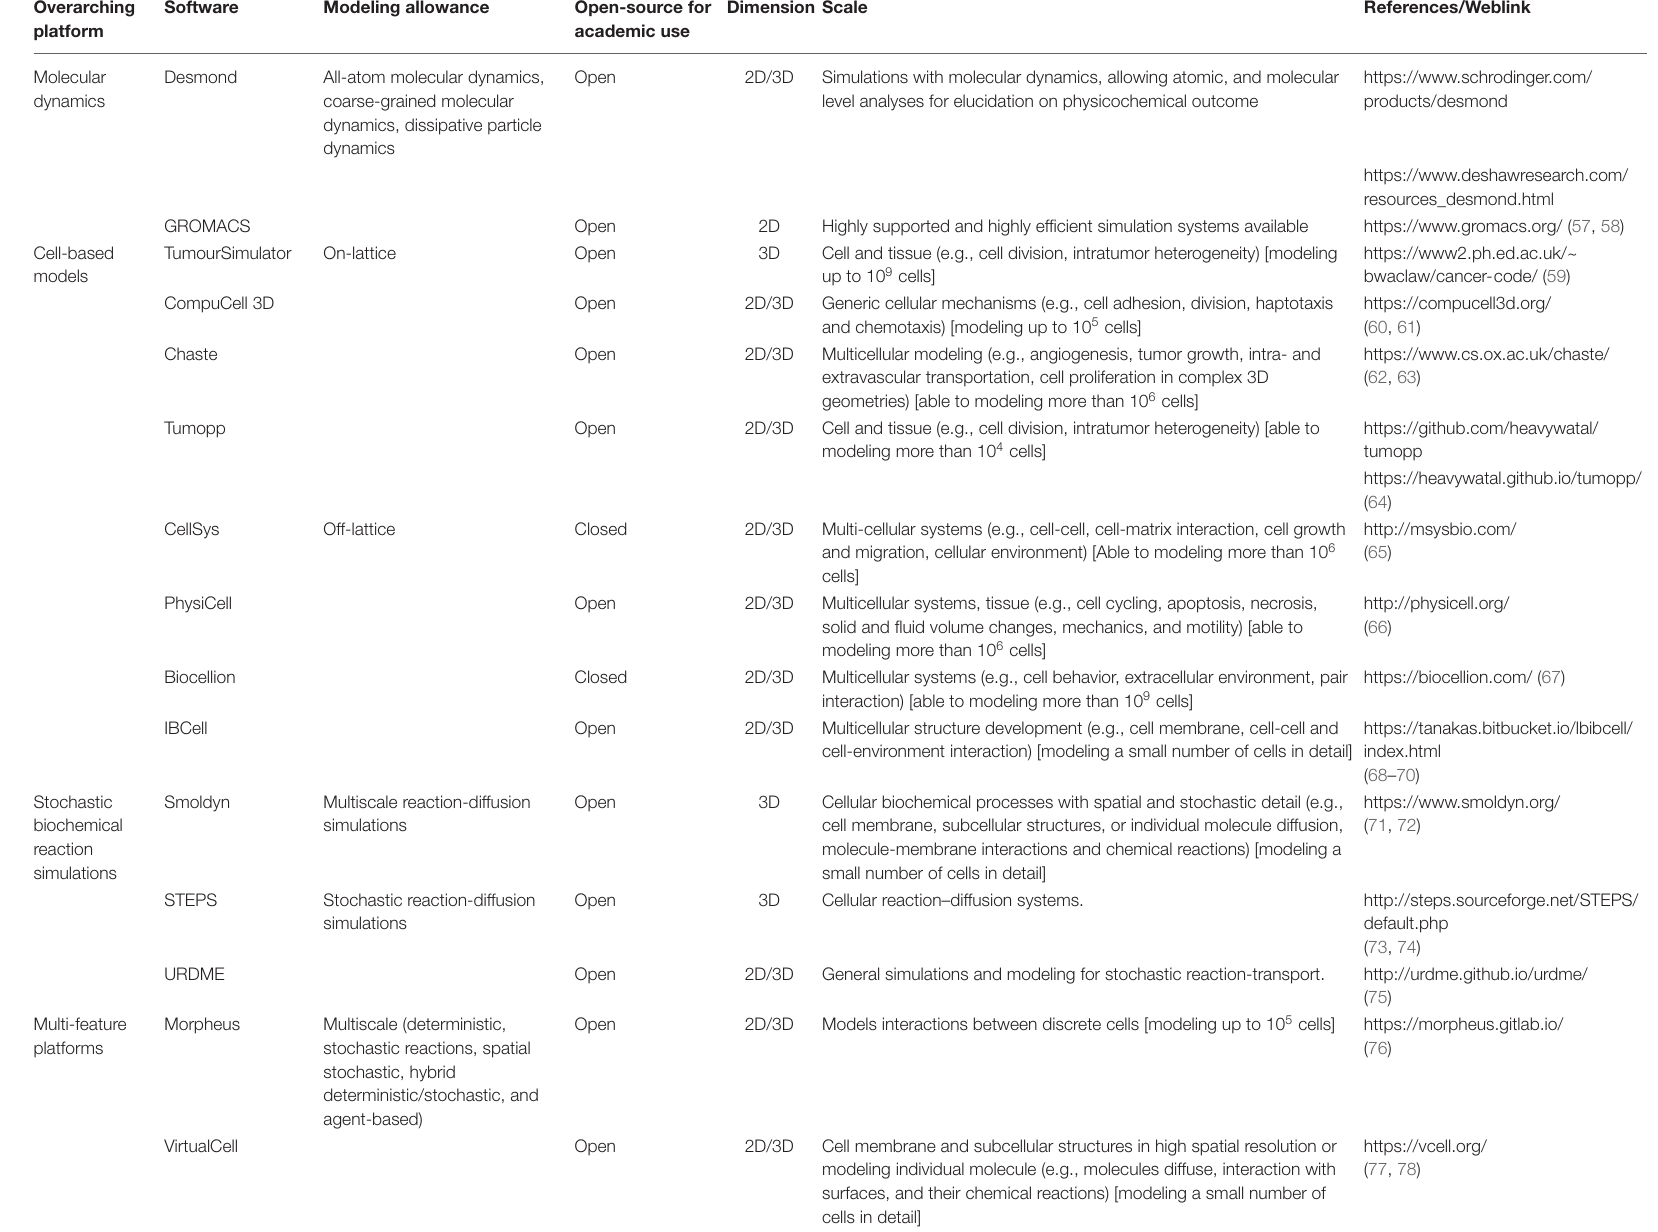
TABLE 2 | Potential simulation tools for modeling NP in vivo behavior. Overarching